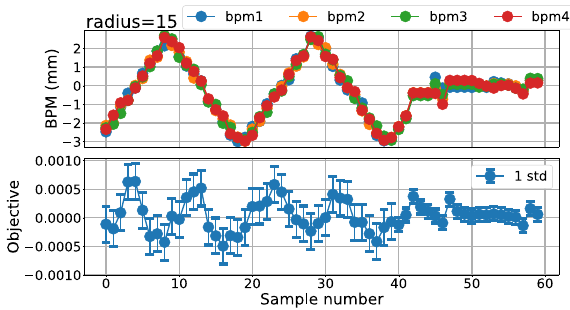
FIG. 10. The final experiment is performed by using a radius of 15. The outputs is not too sensitive to the noise but also sensitive enough to respond to the input changes properly. The first 40 points are the training samples. After training, the algorithm converges very quickly (already reaches a close neighborhood after the first 3 steps, top plot) to an optimum solution, which corresponds to the center position of ð x ¼ 0 ; y ¼ 0 Þ